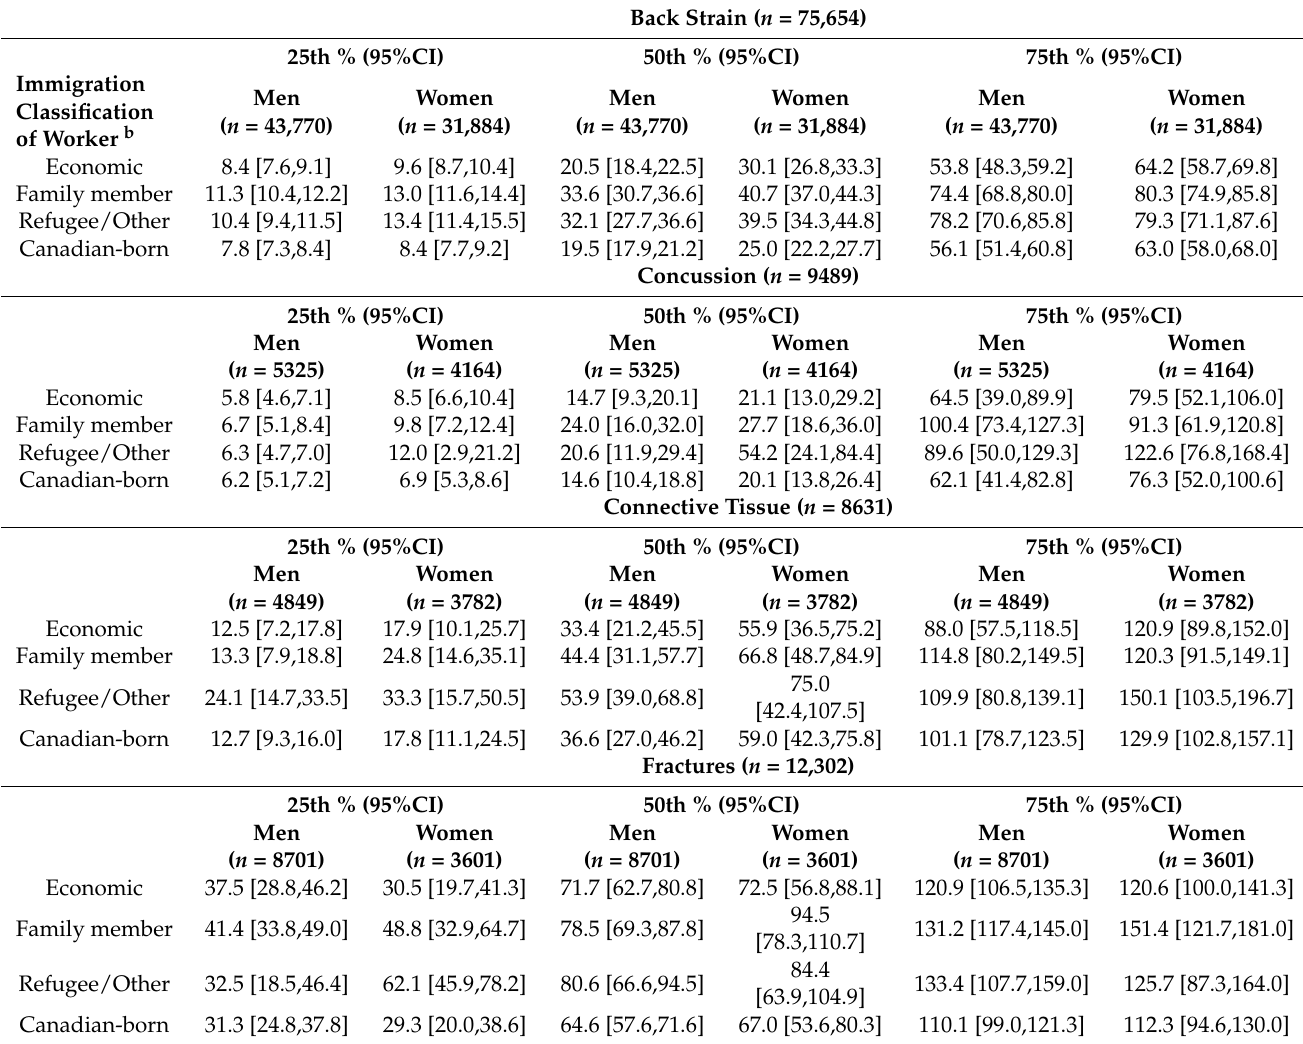
Table 2. Predicted work disability days on workers’ compensation claim benefits for workers by immigration classification at the 25th, 50th and 75th percentiles of the disability days distribution by injury cohort, adjusted quantile regression models a . Back Strain ( n = 75,654) 25th % (95%CI) 50th % (95%CI) 75th %